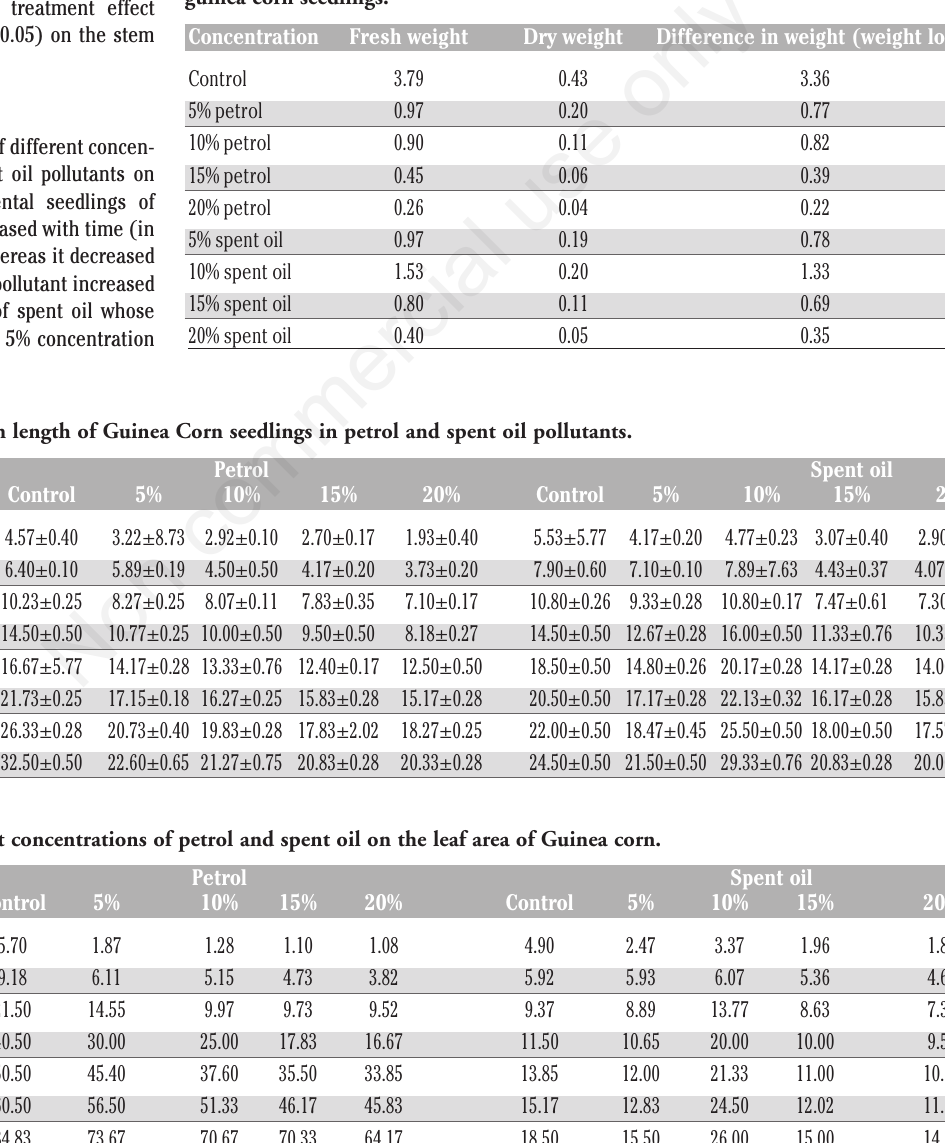
Table 2. The effect of petrol and spent oil pollutants on the fresh and dry weight of guinea corn seedlings.